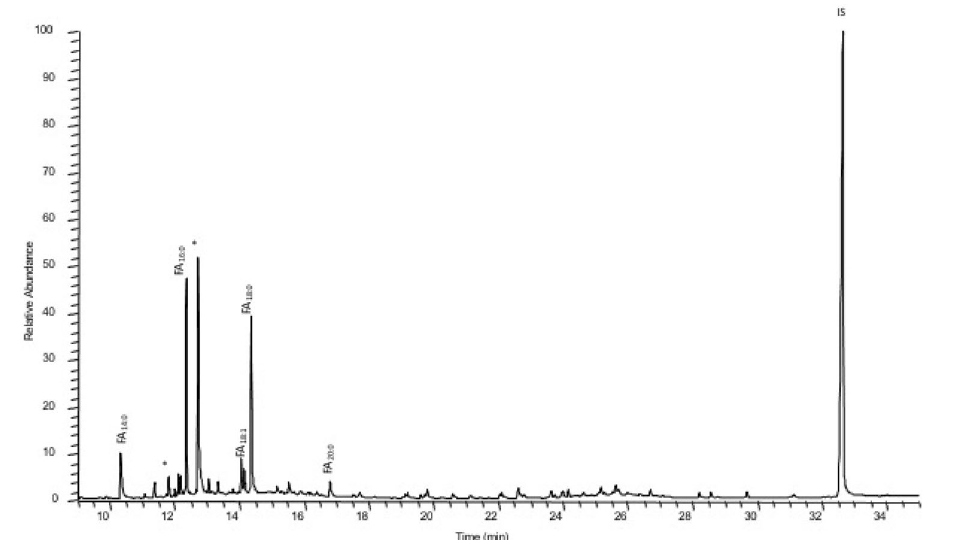
Figure 3. Partial gas chromatogram of total lipid extract of sample CNP21; FAn:0: saturated fatty acids with n carbon atoms; IS: internal standard, C34 n -tetratricontane; *contaminants